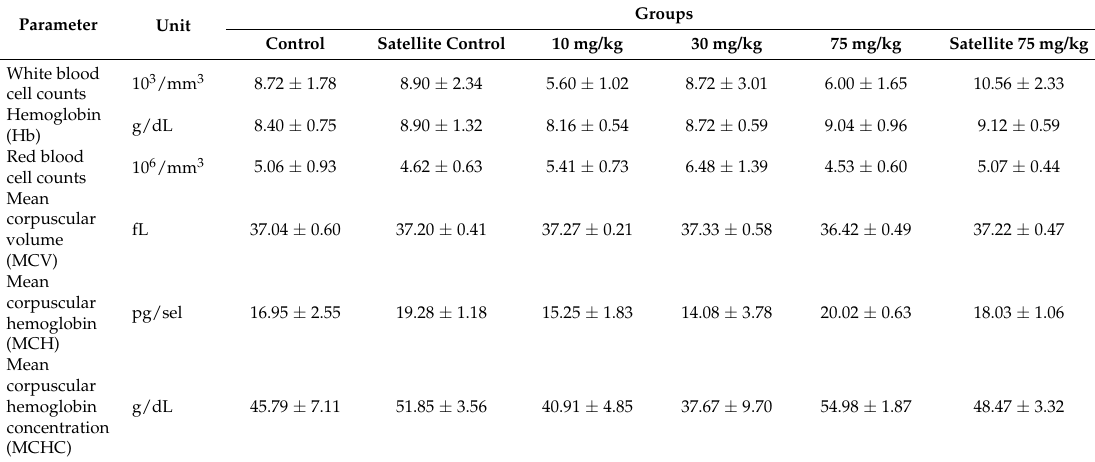
Table 3. Hematological profile of male rats treated with different doses of the film formulation for 28